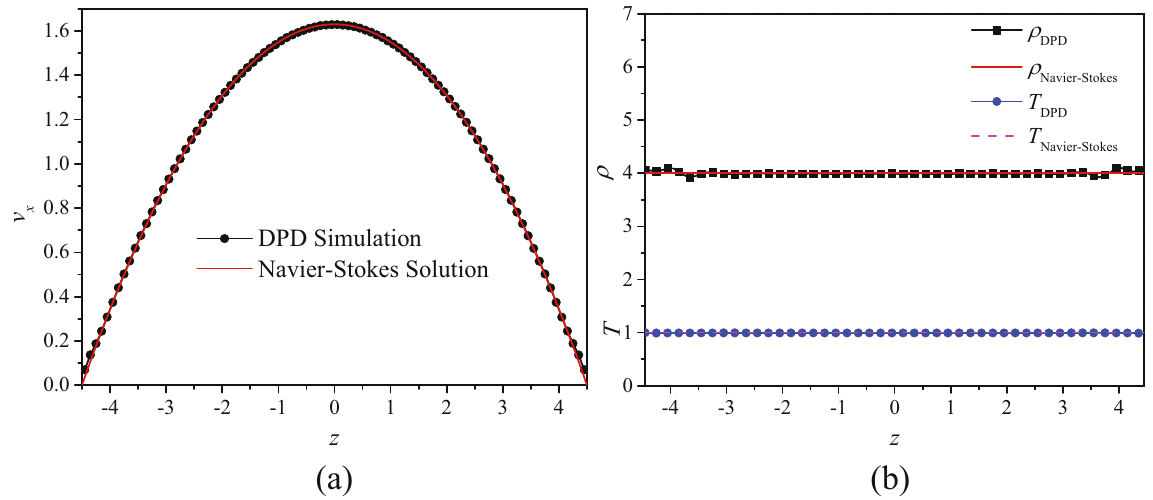
Figure 2: DPD simulation results compared to the analytical solutions for the pressure - driven slit fl ow of simple DPD fl uids: ( a ) velocity pro fi les and ( b ) density and temperature pro fi